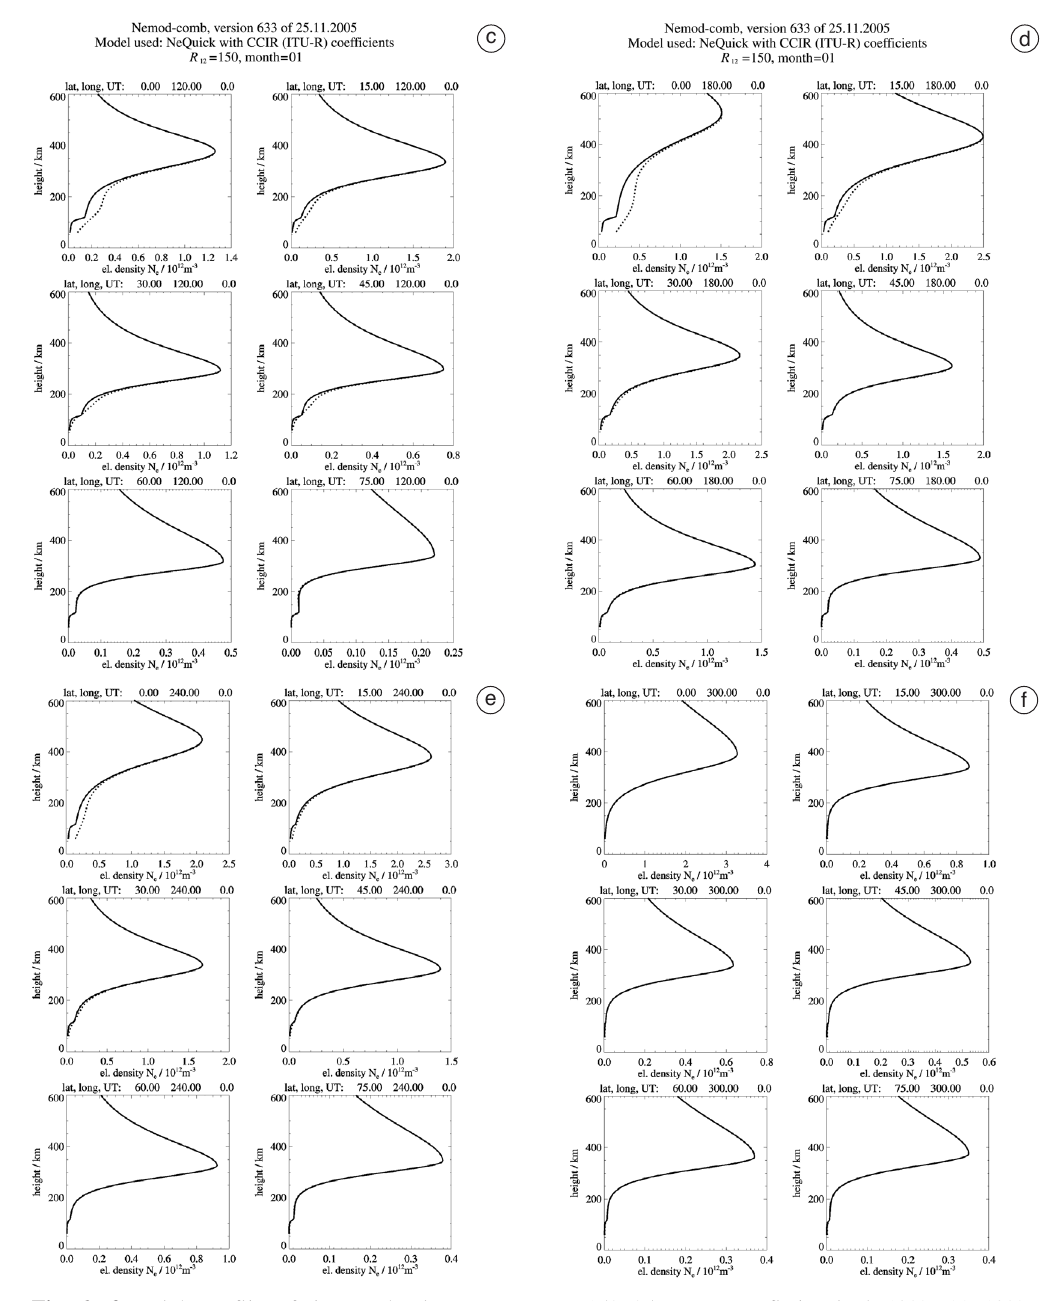
Fig. 3c-f. Height profiles of electron density: January; R 12 = 150; 0 h UT; geografic longitude 120°E (c), 180°E (d), 240°E (e), 300°E (f); 8 h LT (c), 12 h LT (d), 16 h LT (e), 20 h LT (f); geografic latitudes 0°N ( top left ) to 75°N ( bottom right ), latitude spacing 15°. Solid curves: revised NeQuick, dotted curves: NeQuick, old